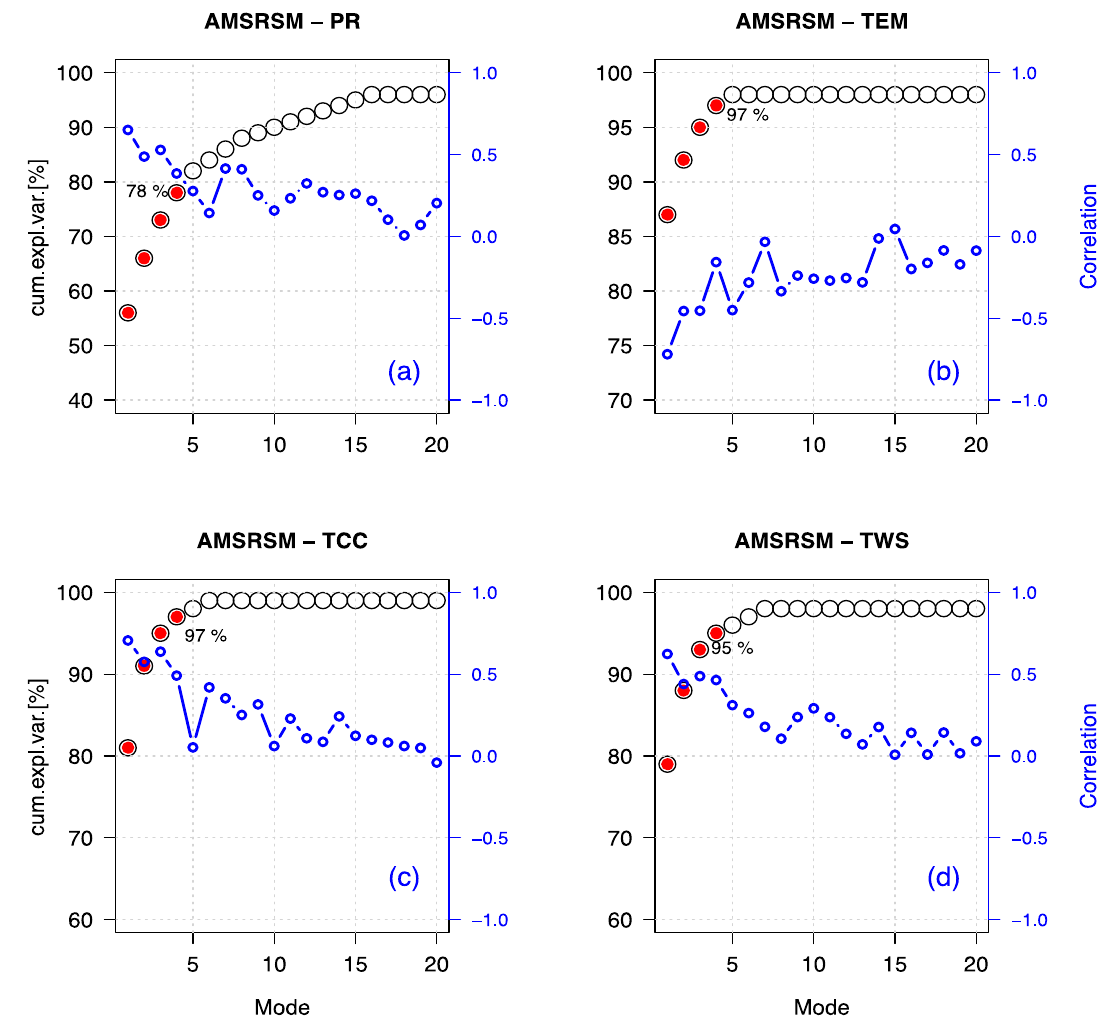
Figure 8. The cumulative squared covariance coefficient (SCF) percentage and correlation coefficients as a function of MCA mode between ( a ) AMSR soil moisture (AMSRSM) and precipitation (PR), ( b ) AMSR soil moisture (AMSRSM) and temperature (TEM), ( c ) AMSR soil moisture (AMSRSM) and total cloud cover (TCC), and ( d ) AMSR soil moisture (AMSRSM) and total water storage (TWS).